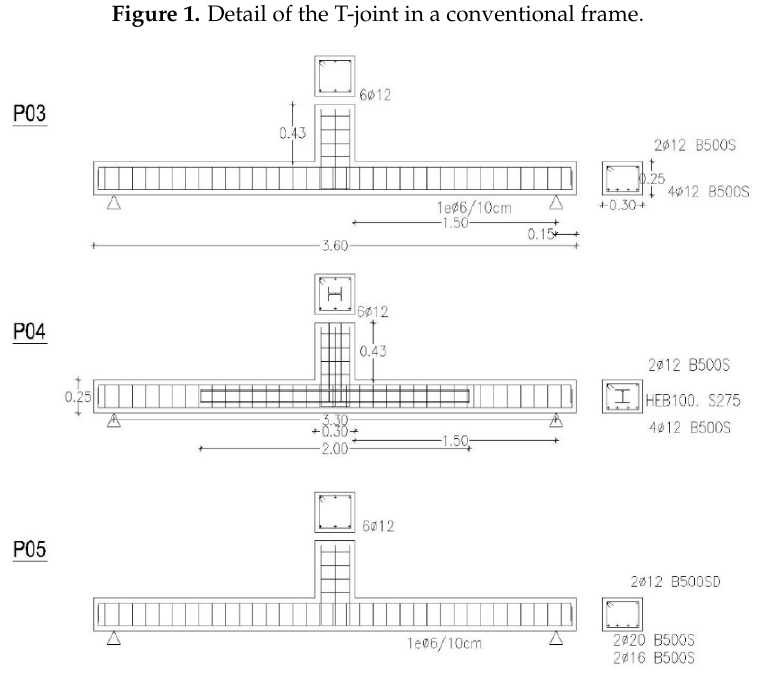
Figure 2. Models P03, P04, and P05.